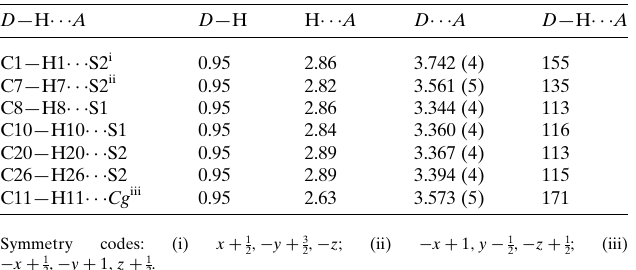
Table 1 Hydrogen-bond geometry (A˚ , (cid:3) ) for I . Cg is the centroid of the C15–C20 ring.